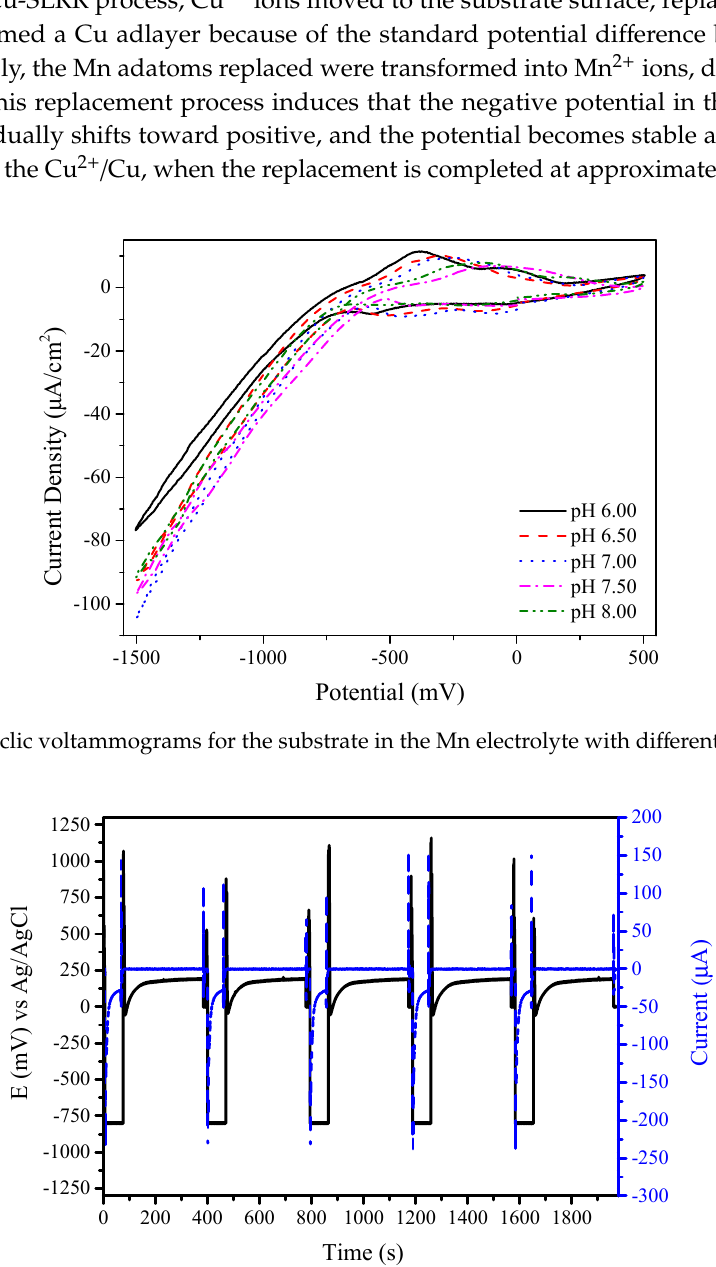
Figure 2. Time–potential–current curves for the first five cycles of underpotential deposition (UPD)- Mn and surface-limited redox replacement (SLRR)-Cu. and surface-limited redox replacement